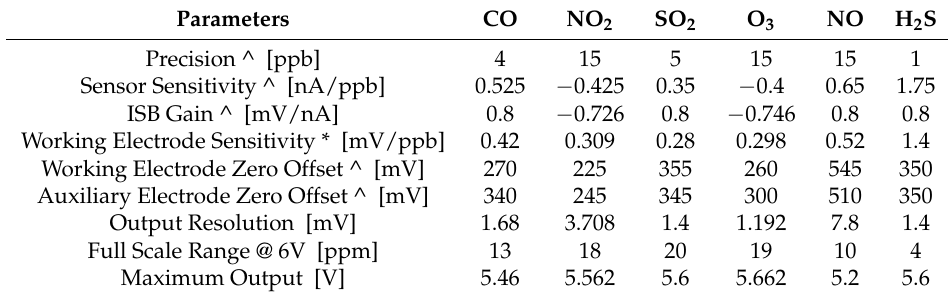
Table 1. Technical detail of Alphasense sensors and Individual Sensor Boards